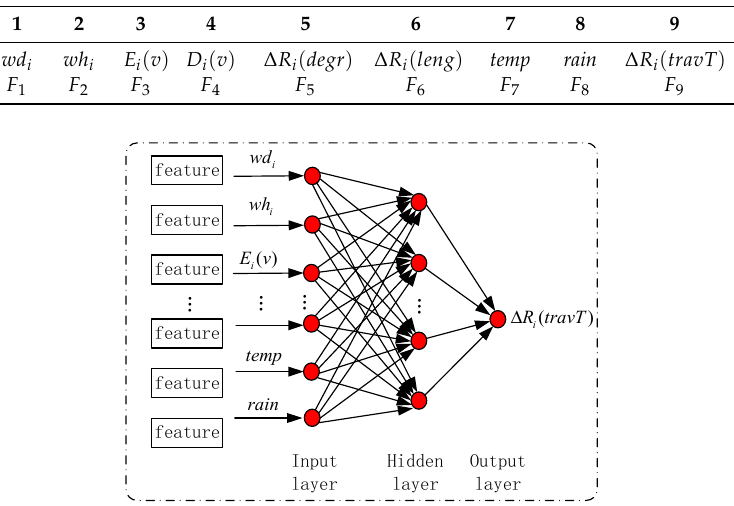
Table 3. Input features and corresponding output feature.